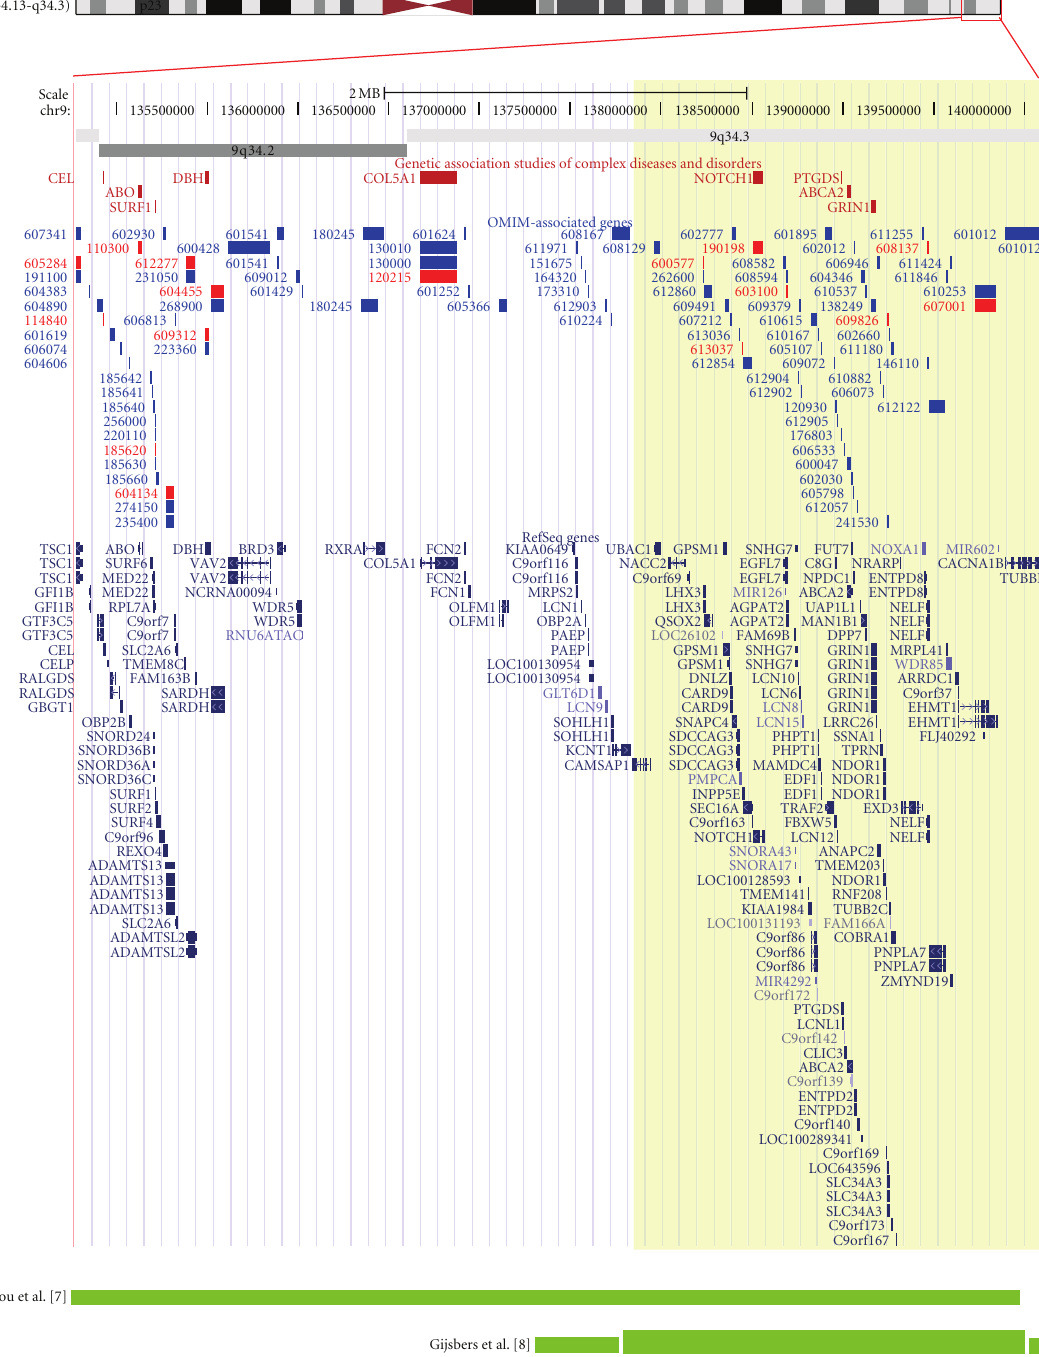
Figure 3: Location and extent of 9q34 duplications. UCSC Genome Browser (March 2006 (hg18) assembly) view of the chromosomal region 9q34.13-q34.3 (chr9:134,776,210-140,171,337) is shown, together with Refseq, OMIM, and GAD genes. The bottom panel shows the location and extent of the 9q34.3-qter region of the patient described here, and of other cases reported in the literature. Note: the region highlighted in yellow is the ∼ 2.3 Mb region duplicated in our case, and the thicker green block represents the triplicated region reported by Gijsbers et al.